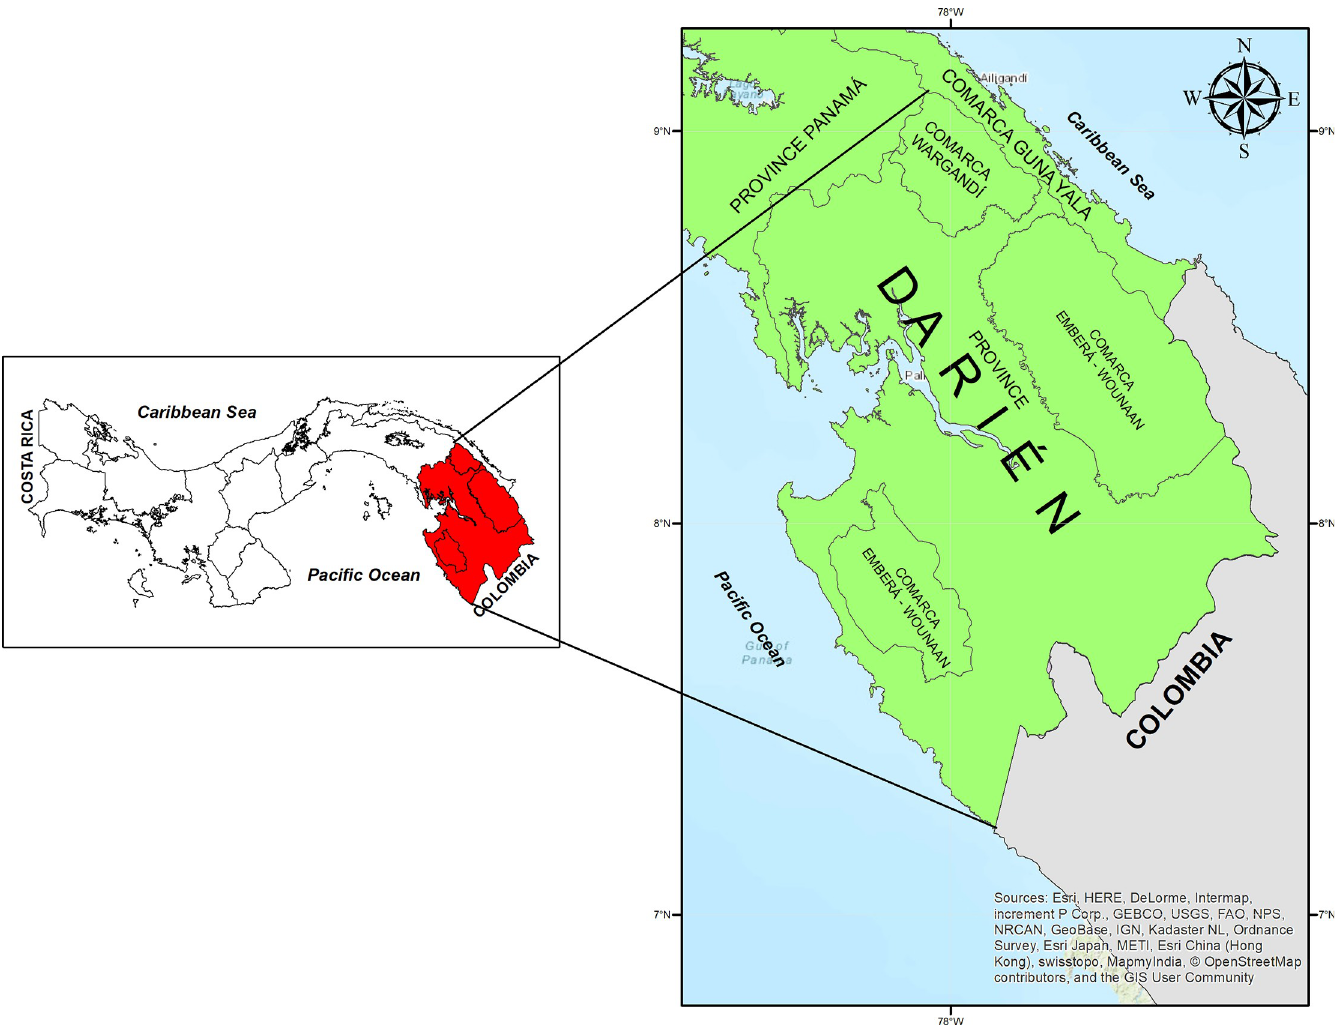
Fig 1. Geographic location of the Darie´n Region, Panama.